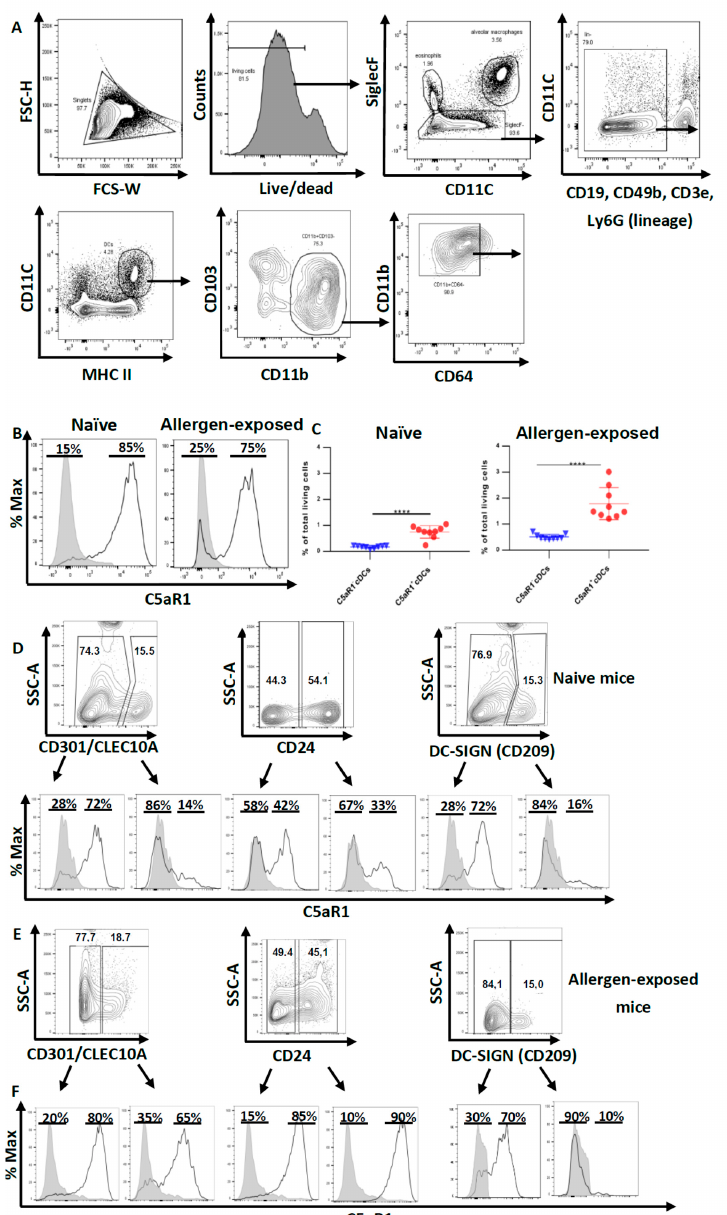
Figure 1. Pulmonary CD11b + cDCs are a heterogeneous cDC population. ( A ) Gating strategy to identify pulmonary CD11b + cDCs in WT naïve and allergen-exposed BALB / c mice. CD11b + cDCs were identified as SiglecF − lin − CD11C + MHC-II hi CD103 − CD11b + CD64 − cells. ( B ) Histograms showing the expression of C5aR1 in pulmonary CD11b + cDCs from both naive mice (left panel) and animals exposed 1 × i.t. to HDM / OVA (right panel). The data shown in the histograms are representative of 10 mice. ( C ) Frequencies of pulmonary CD11b + C5aR1 − and CD11b + C5aR1 + cDCs in naïve (left panel) and mice immunized 1 × i.t. with HDM / OVA (right panel). Shown are the frequencies of the two subsets within total lung cells as the mean ± standard error of the mean (SEM), n = 10. Di ff erences between groups were determined by unpaired t-test; **** p < 0.0001. ( D , E ) Dot plots showing the expression of CD301, CD24 and CD209 in pulmonary CD11b + cDCs from ( D ) naive or ( E ) mice exposed 1 × i.t. to HDM / OVA. The histograms show the frequency of C5aR1 + cells within the CD11b + cDC population that were either CD301, CD24 or CD209 positive or negative. ( F ) Quantitative evaluation of the frequency of C5aR1 + or C5aR1 − cells within the subsets of CD301, CD24 or CD209 positive or negative cells. The gray histograms represent Fluorescence minus one (FMO)